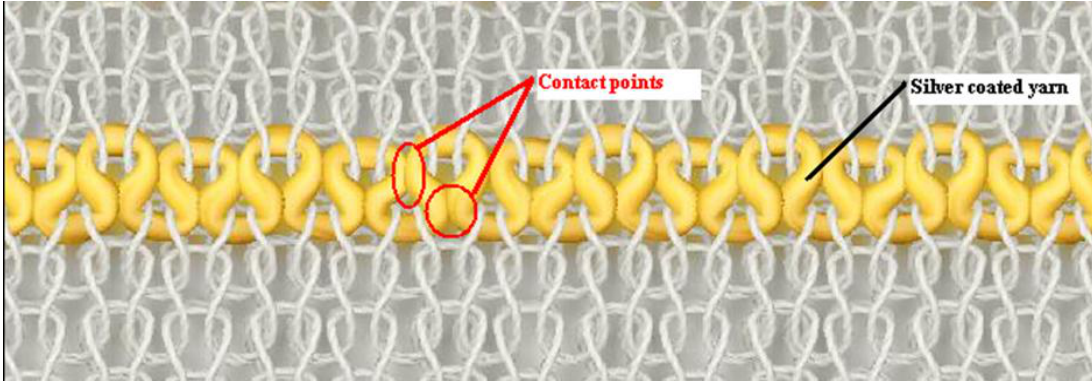
Figure 4. Schematic diagram of sensor design showing the geometry of the conductive